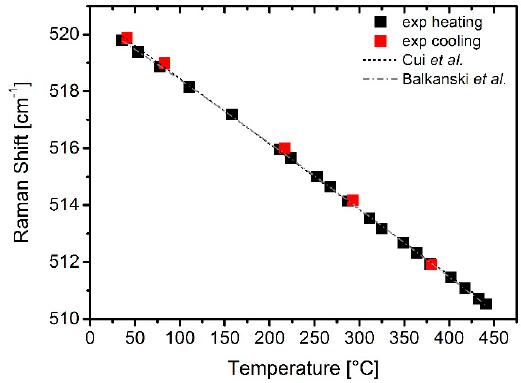
Figure 4. Calibration (heating/cooling) of peak position with fitting curves.